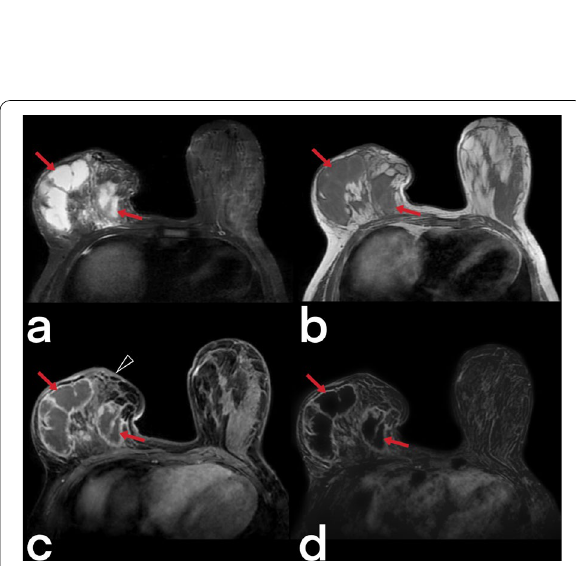
Fig. 22 Breast MR images of a 39-year-old female. T2 weighted image ( a ), T1 weighted image ( b ) post-contrast ( c ), and subtracted image ( d ) demonstrate thickening of the skin (arrowhead) and multiple abscesses (arrows) with peripheral enhancement in the right breast